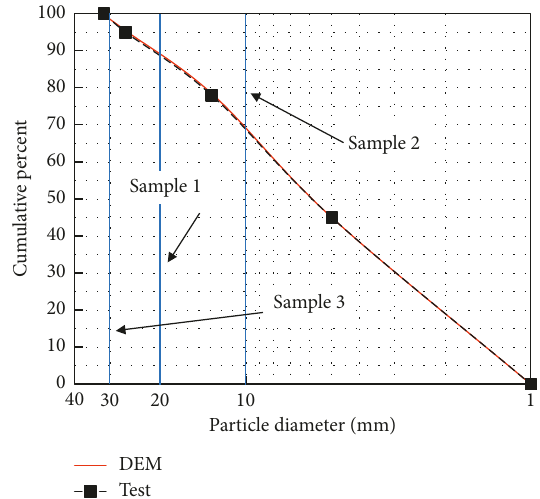
Figure 2: Grain size distribution of the laboratory test and DEM